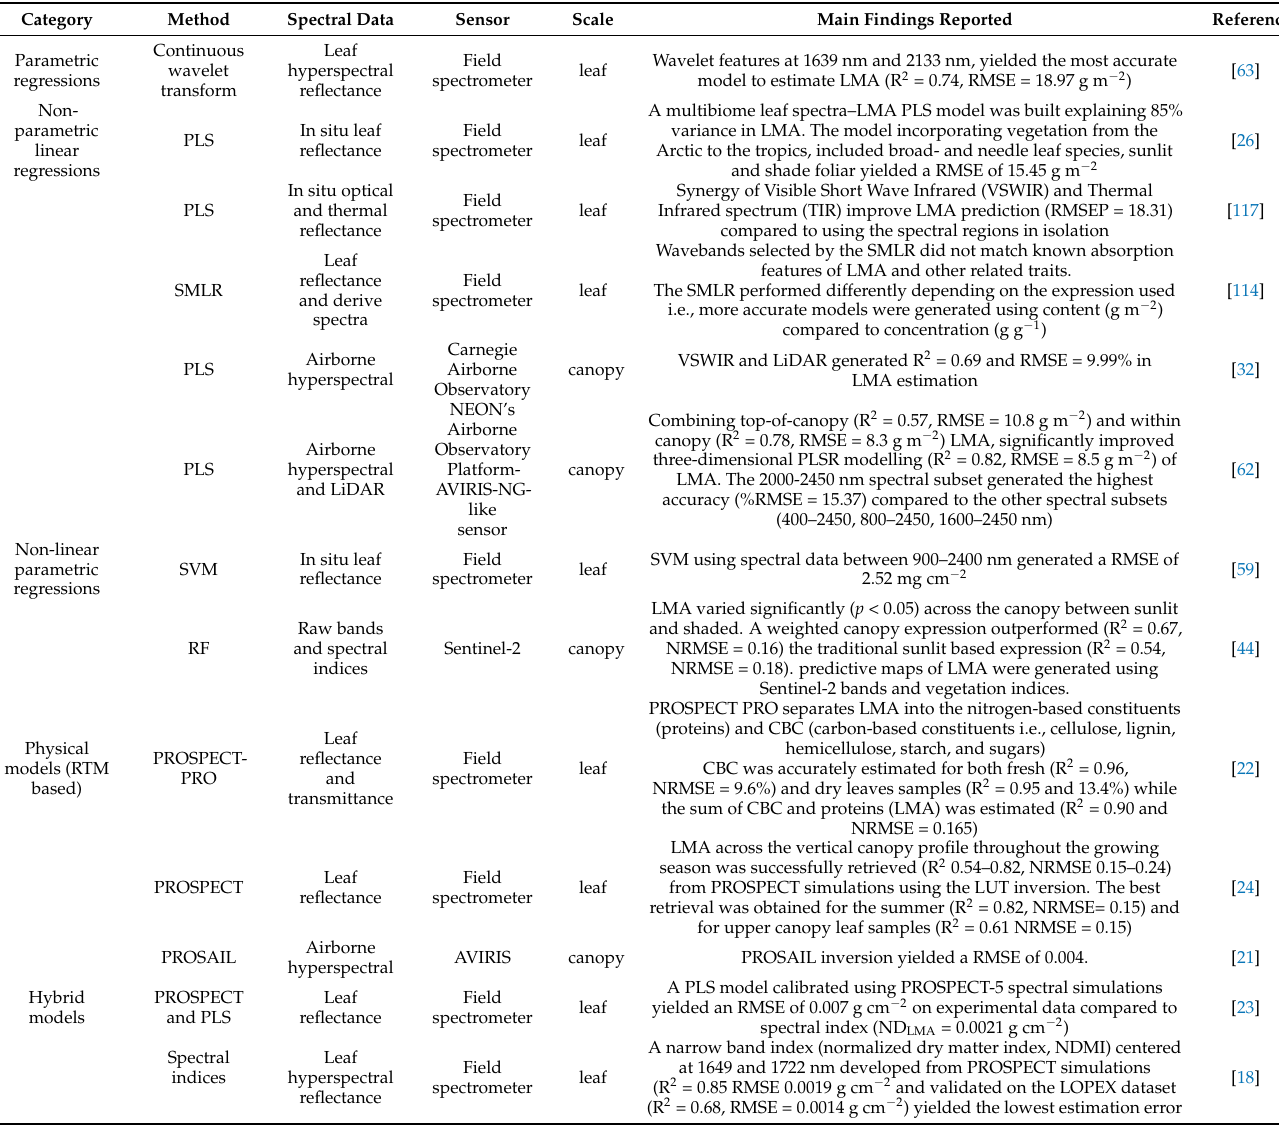
Table 2. Studies that estimated/retrieved LMA from remote sensing